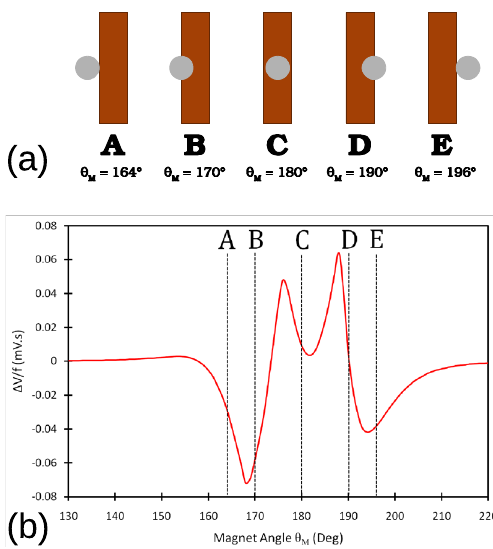
Figure 3. ( a ) Sketch of key magnet positions along with their magnet rotation angles θ M from Fig. 2. ( b ) Frequency-normalized (cid:31) V (equation (10)) versus magnet angle θ M for airgap of 3.3